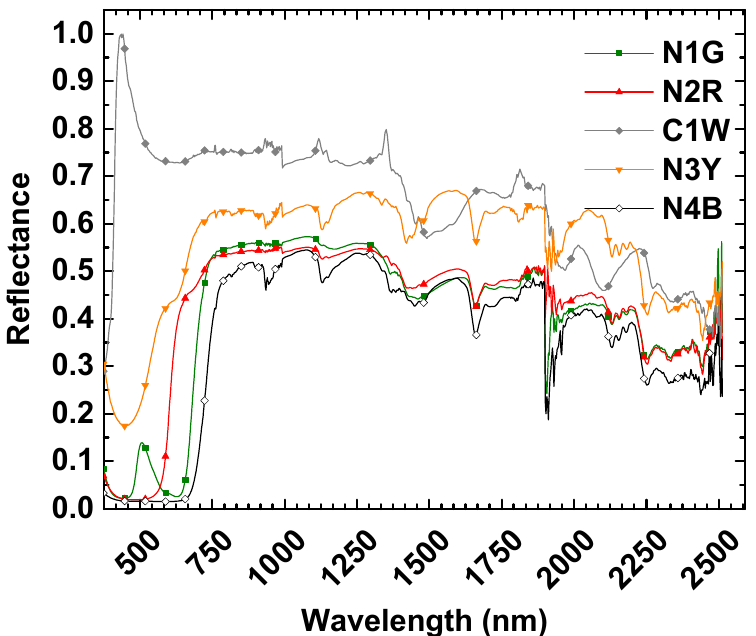
Figure 3. Reference spectral signatures of the artificial target materials acquired from in-situ reflectance measurements.